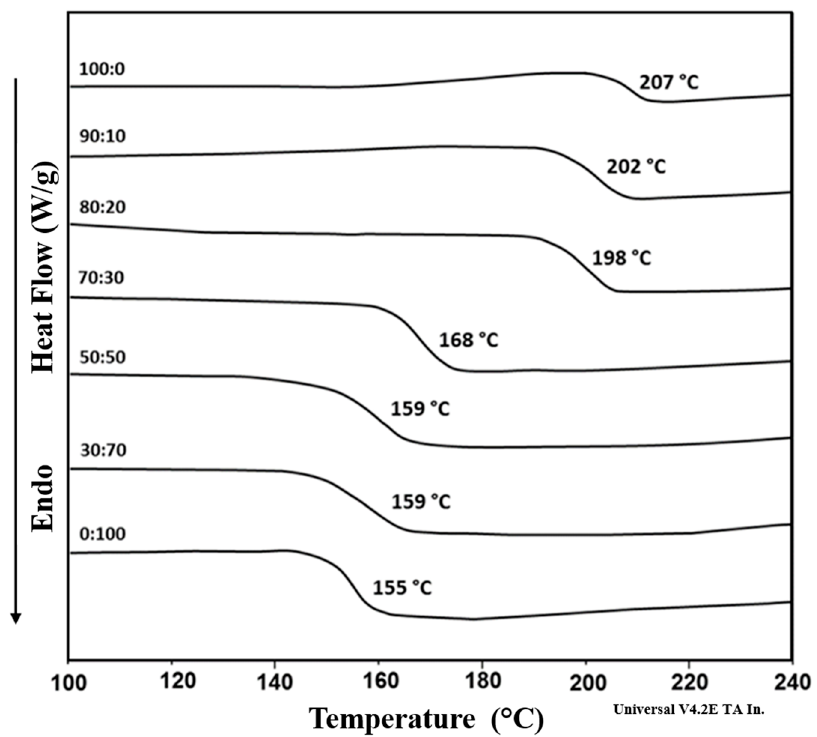
Figure 7. Thermograms of the second heating cycle of P(ESES-co-ESDPA) copolymers.